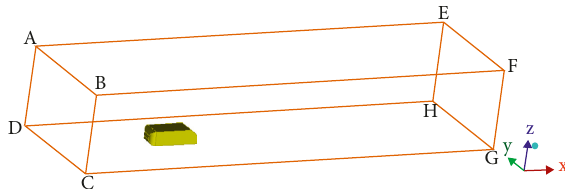
Figure 3: Computational domain and coordinate system.